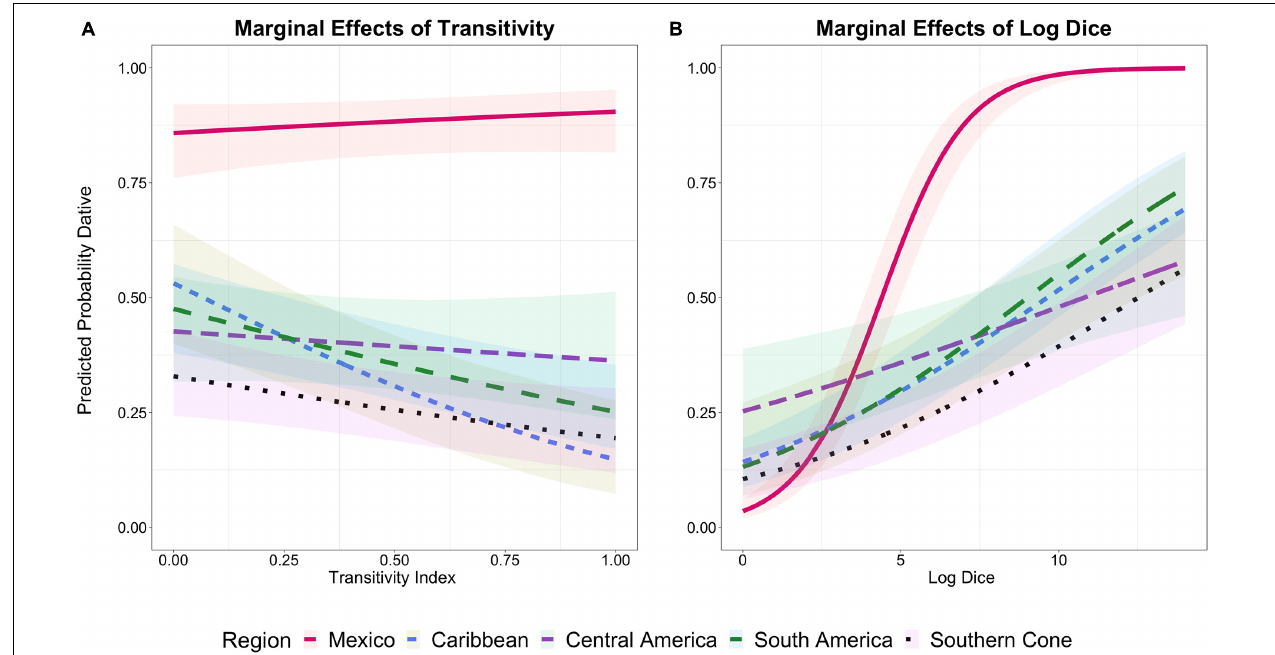
FIGURE 2 | Marginal effects of Log Dice and Transitivity Index on clitic case. The y -axis represents the predicted probability of the dative clitic. In (A) , the x -axis represents the Transitivity Index between 0-1 and in (B) the Log Dice between 0 and 14.